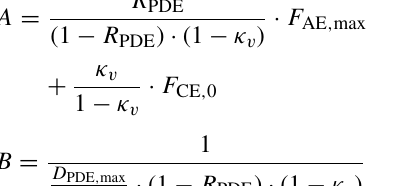
Fig. 2. Theoretical construct of the CE [8]. The CE consists of three elements: Active element AE, parallel damping element PDE, and serial element SE. y 0 = 0 is the origin of the CE, y 1 represents the length of the AE/PDE and y 2 the length of the whole CE.